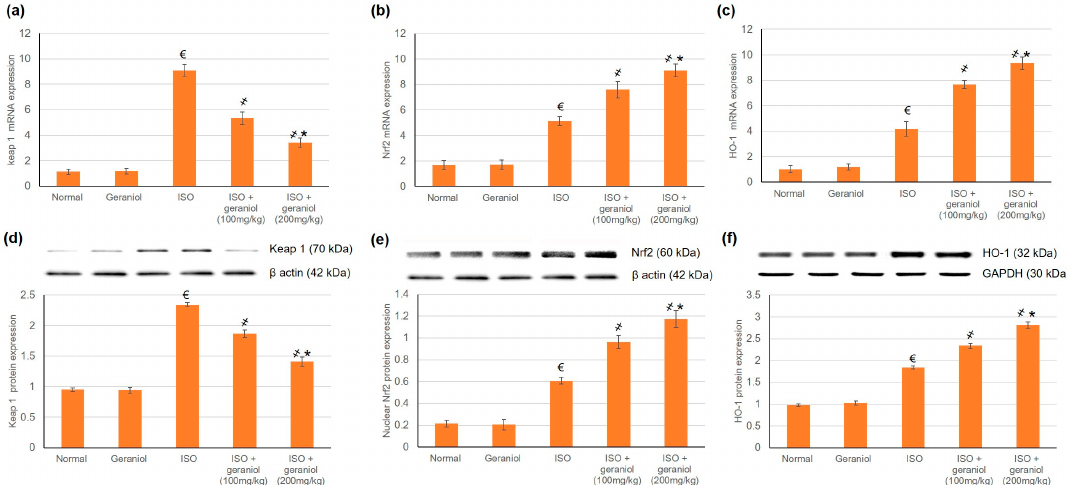
Figure 4. E ff ects of geraniol pretreatment (100 or 200 mg / kg) on the Keap1 / Nrf2 / HO-1 pathway in the ISO-induced rat MI model. Gene expression was assessed by determination of the mRNA levels of ( a ) Keap 1, ( b ) Nrf2 and ( c ) HO-1. Protein expression was assessed by determination of the protein levels of ( d ) Keap 1, ( e ) nuclear Nrf2 and ( f ) HO-1 via Western blot analysis. ISO: isoproterenol. All values were stated as mean ± SD ( n = 6). € , p < 0.05 compared to the normal group;